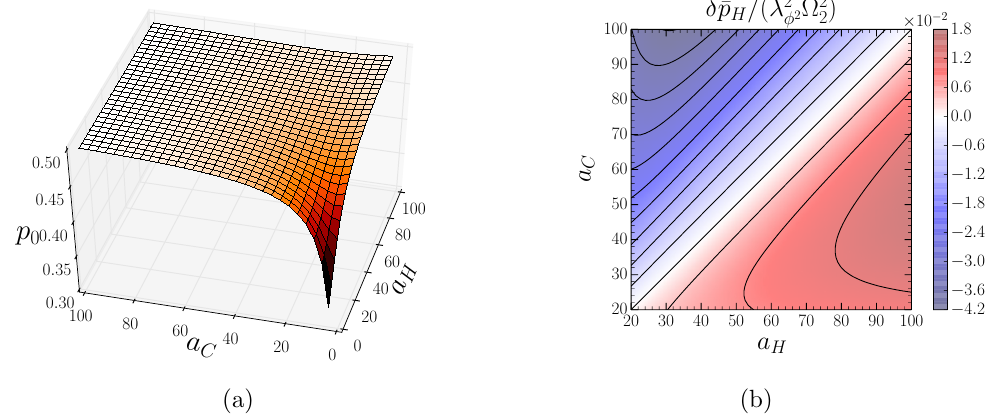
Figure 7. For the quadratically coupled scalar interaction, with v = 0 : 8 and (cid:10) 2 = (cid:10) 1 = 2; (cid:12)gure (a) shows the behaviour of the critical probability for completing the thermodynamic cycle and (b) the correction (cid:14) (cid:22) p H as a function of the critical probability. Red regions show where we get positive work and blue negative.